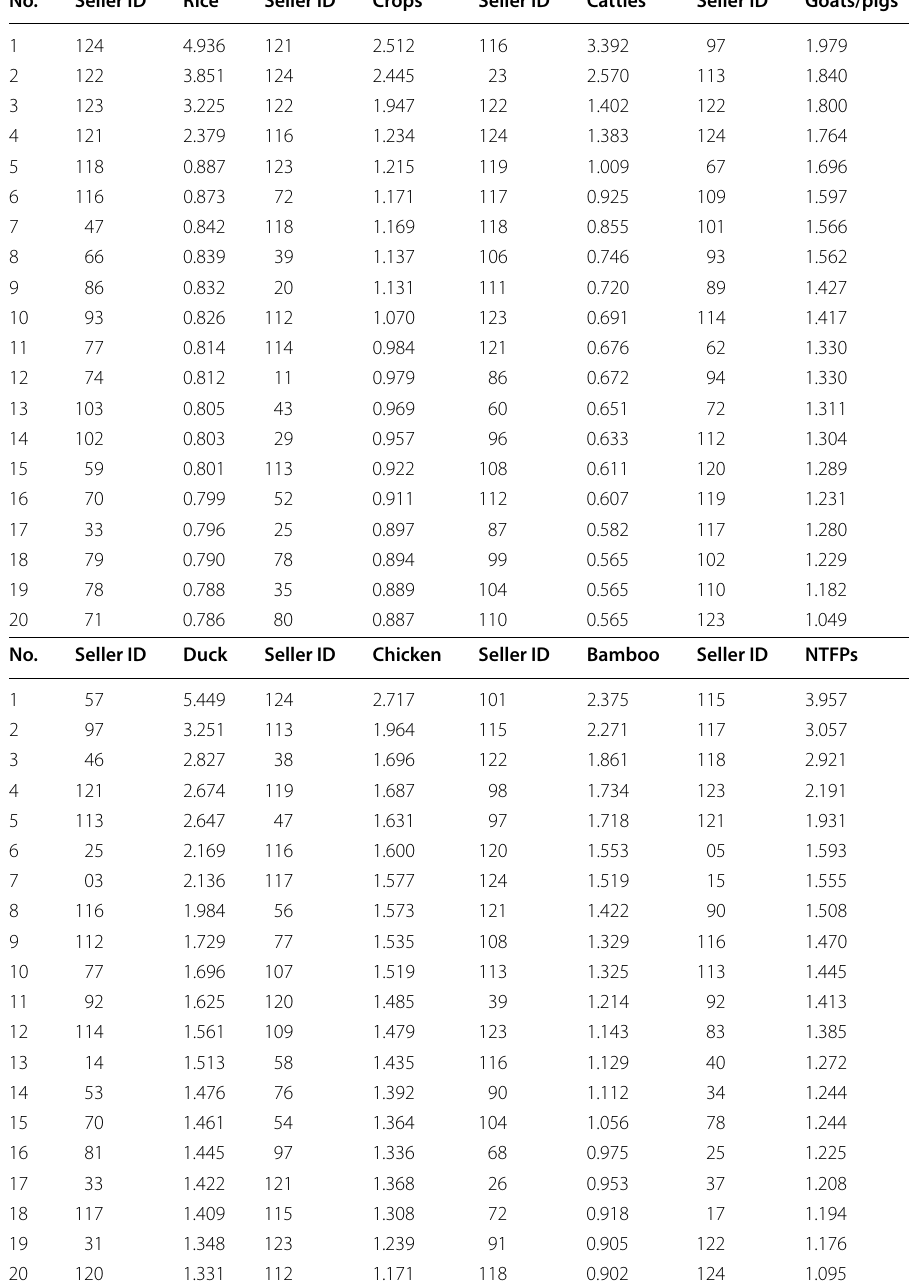
Table 11 Forward linkage values for major product transactions